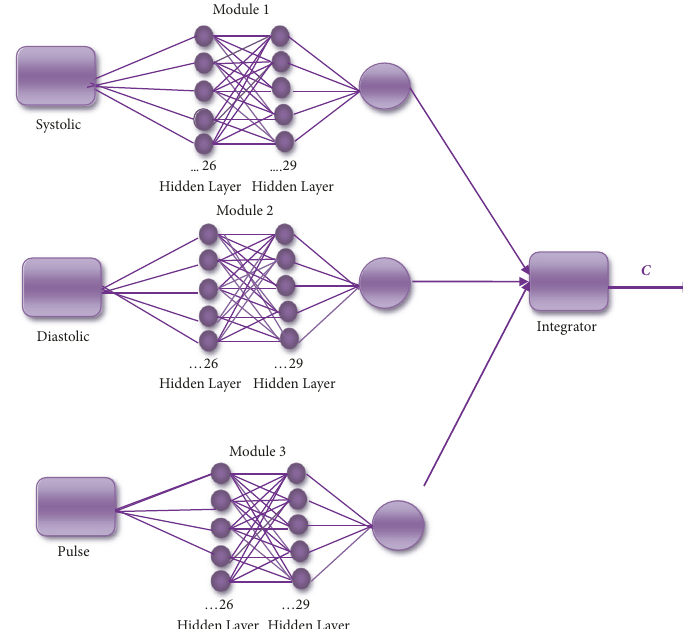
Figure 4: The best architecture for MNN with the training method